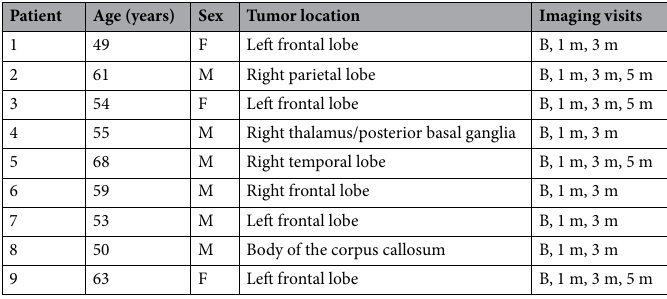
Table 1. Clinicopathologic characteristics of the patient